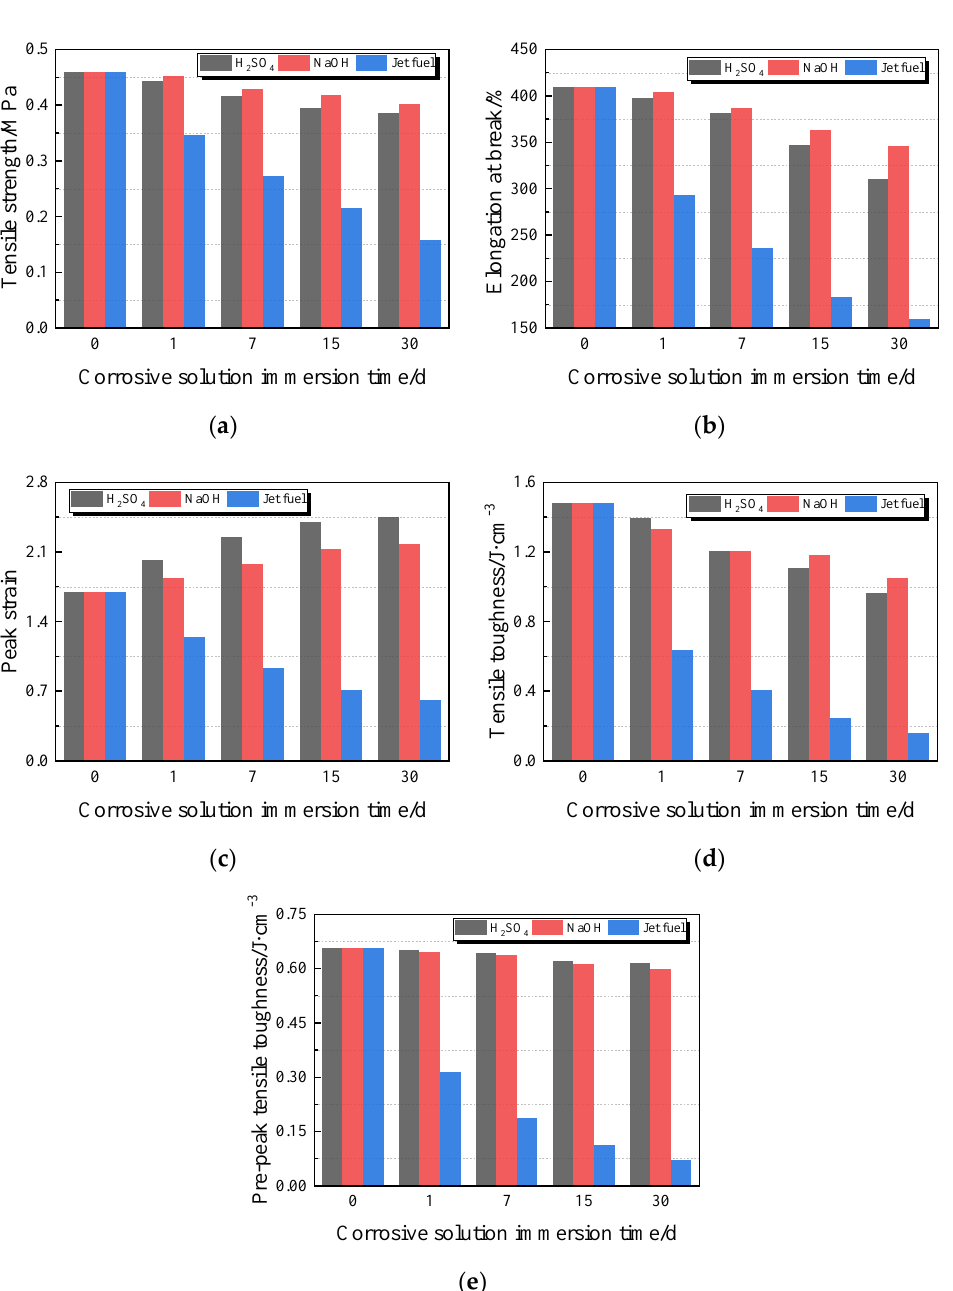
Figure 13. Tensile properties of PCFC under different corrosion solution immersion time. ( a ) Tensile